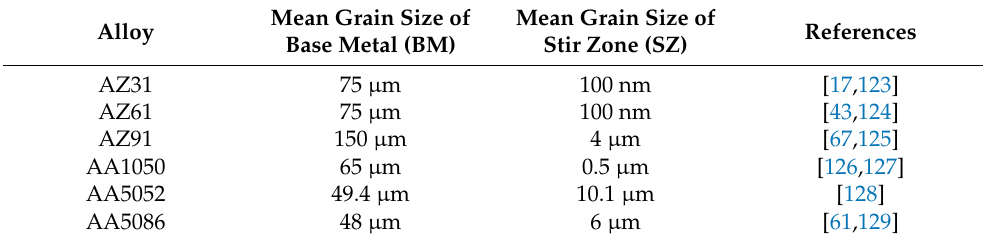
Figure 7. ( a ) Optical macrograph of the transverse cross-section of the Al-Mg joint welded in air with FSW (Reprinted with permission from ref. [14]. Copyright 2020 Elsevier B.V.), and EBSD maps of the grain structures of the FSP stir zone magnesium alloy sam- ples after (b) 1 pass, (c) 2 passes, (d) 4 passes and (e) 6 passes of FSP [102]. Table 6. Evolutions of mean grain size of some alloys after FSW and FSP techniques. Alloy Mean Grain Size of Base Metal (BM)